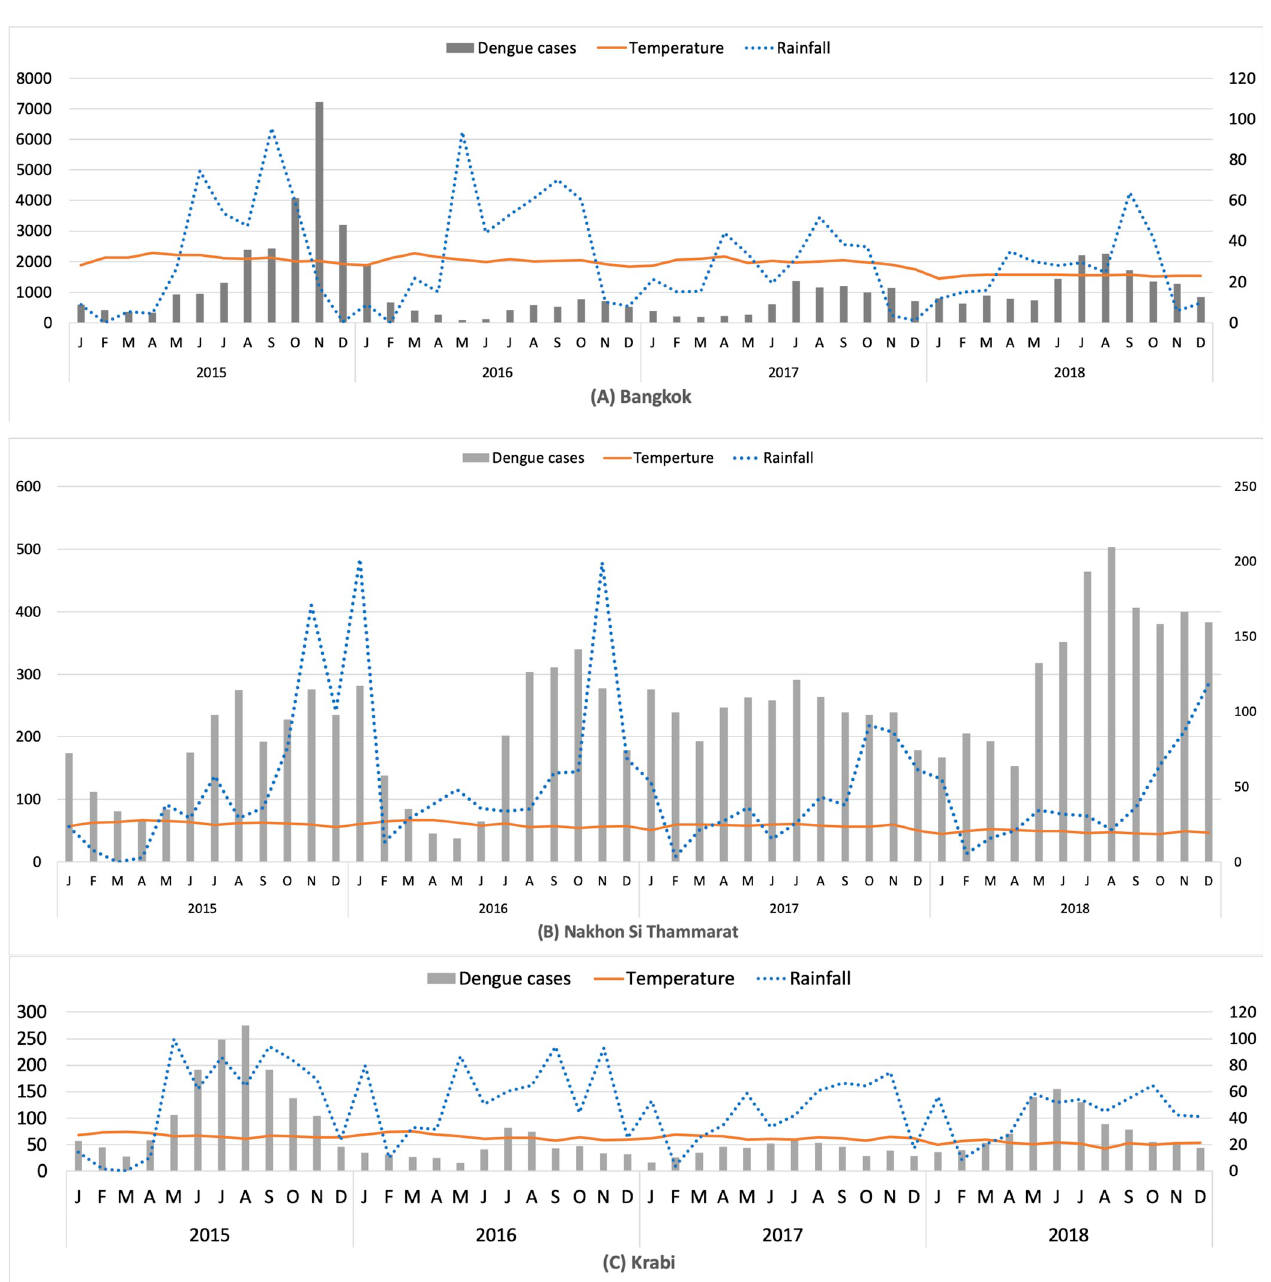
Fig 2. Monthly dengue cases (bar), rainfall (blue dotted line), and temperature (orange line) between 2014 and 2018 in the study areas. The left y-axis represents the number of dengue cases, the right y-axis represents the temperature (LST) and the amount of rainfall (RF).